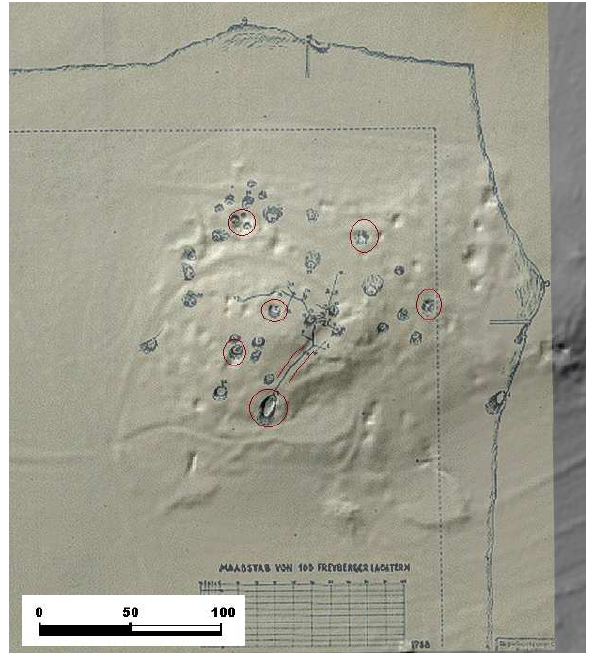
Figure 3. M ě dník - DTM in form of shaded relief and